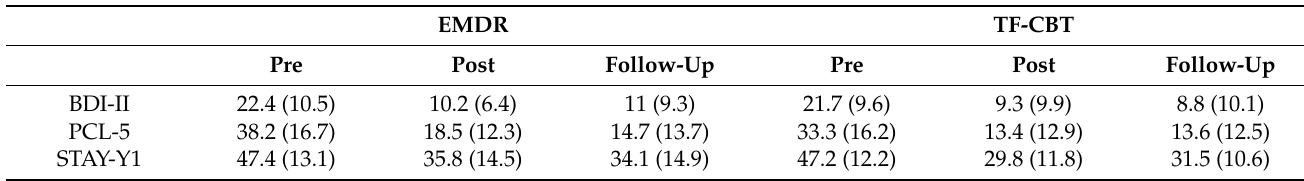
Table 2. Scores of the three psychological tests at pre-treatment, post-treatment and follow-up for the EMDR and TF-CBT groups. Values are mean